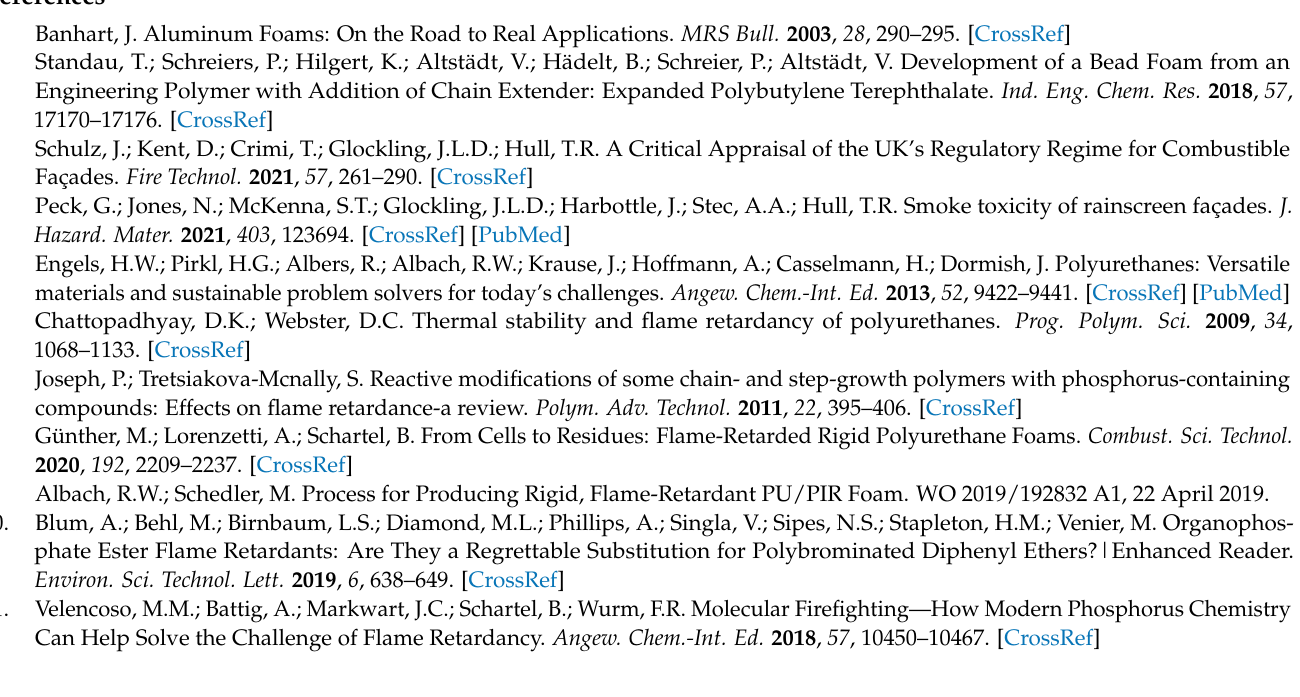
NMR spectrum of AA-DOPO (solvent: DMSO-d 6 ), Figure S21: 1 H, 13 C, and 31 P NMR spectrum of FU-DOPO (solvent: DMSO-d 6 ), Figure S22: 1 H, 13 C, and 31 P NMR spectrum of BA-DOPO (solvent: DMSO-d 6 ), Figure S23: 1 H, 13 C, and 31 P NMR spectrum of TA-DOPO (solvent: DMSO-d 6 ), Figure S24: 1 H, 13 C, and 31 P NMR spectrum of FU-EP (solvent: DMSO-d 1 H, 13 C, and 31 P NMR 6 ), Figure S25: spectrum of FU-BP (solvent: DMSO-d 6 ), Figure S26: 1 H, 13 C, and 31 P NMR spectrum of TA-BP (solvent: DMSO-d 6 ), Figure S27: Dependence of the compression strength on the density of selected IR foams with different FR additives, Table S1: PIR foam compositions studied, Table S2: Compression strengths of the PIR foams with phospha-aldol adducts, Table S3: TGA data of the PIR foams studied (TGA under nitrogen with a scan rate of 10 K · min − 1 ), Table S4: Summary of pyrolysis-GC/MS data obtained for PIR foams with phospha-aldol adducts. Results with phospha-Michael adducts have been published before in [29]. Selected samples are given for comparison. Figure SI-28: MARHE vs. char plots for the control and state-of-the-art PIR foams studied. Figure SI-29: MARHE vs. residue plot for PIR foams with nonreactive BPPO